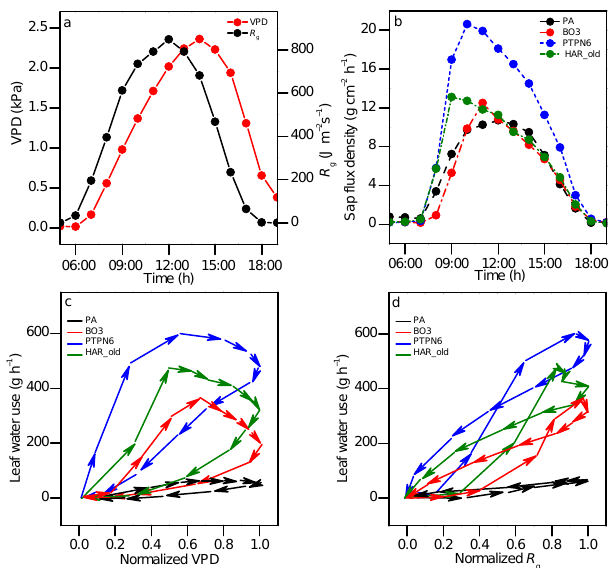
Figure 4. Diurnal course of vapor pressure deficit (VPD) and radi- ation ( R g ) (a) and of sap flux density in four oil palm stands (b) . Leaf water use plotted against hourly averages of normalized VPD (c) and Rg (d) . Average water use estimates based on at least 13 leaves measured simultaneously; average water use rates, VPD and radiation of three sunny days, each point represents one-hourly ob- servation. Data are from the locations PA (2 years old, black ar- rows), BO3 (12 years old, low water use, red arrows), PTPN6 (12 years old, high water use, blue arrows) and HAR_old (25 years old, green arrows). Data were normalized by setting the maximum to one.